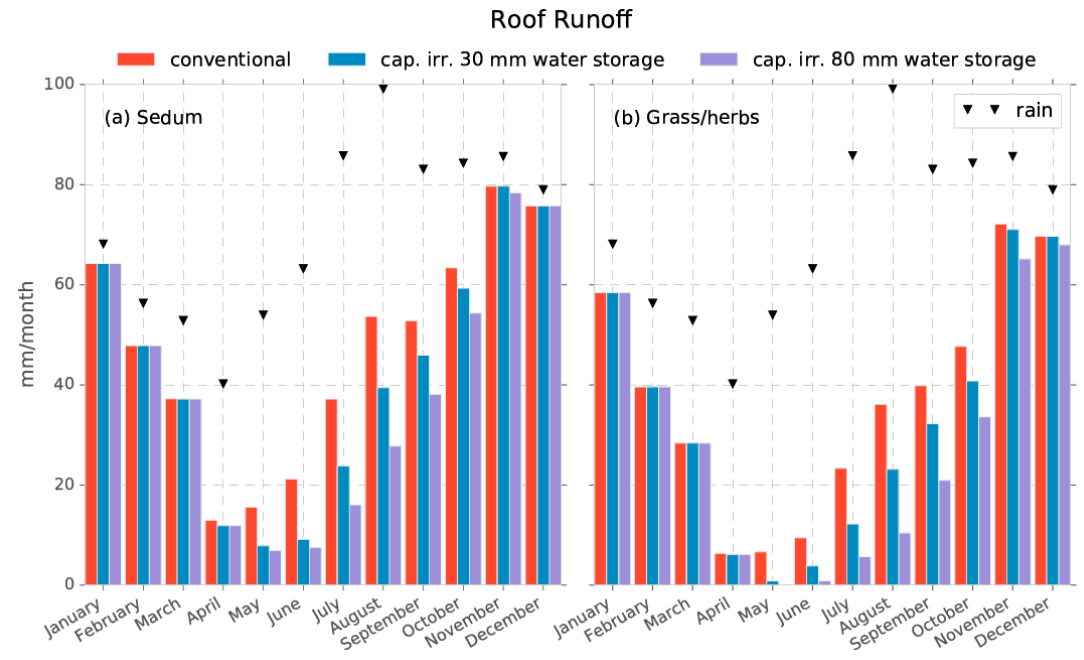
Figure 11. Estimated (with the bucket model) monthly averaged runoff for the six roof setups based on 30 years of Schiphol meteorological data. Black triangles denote the monthly averaged precipitation over the period